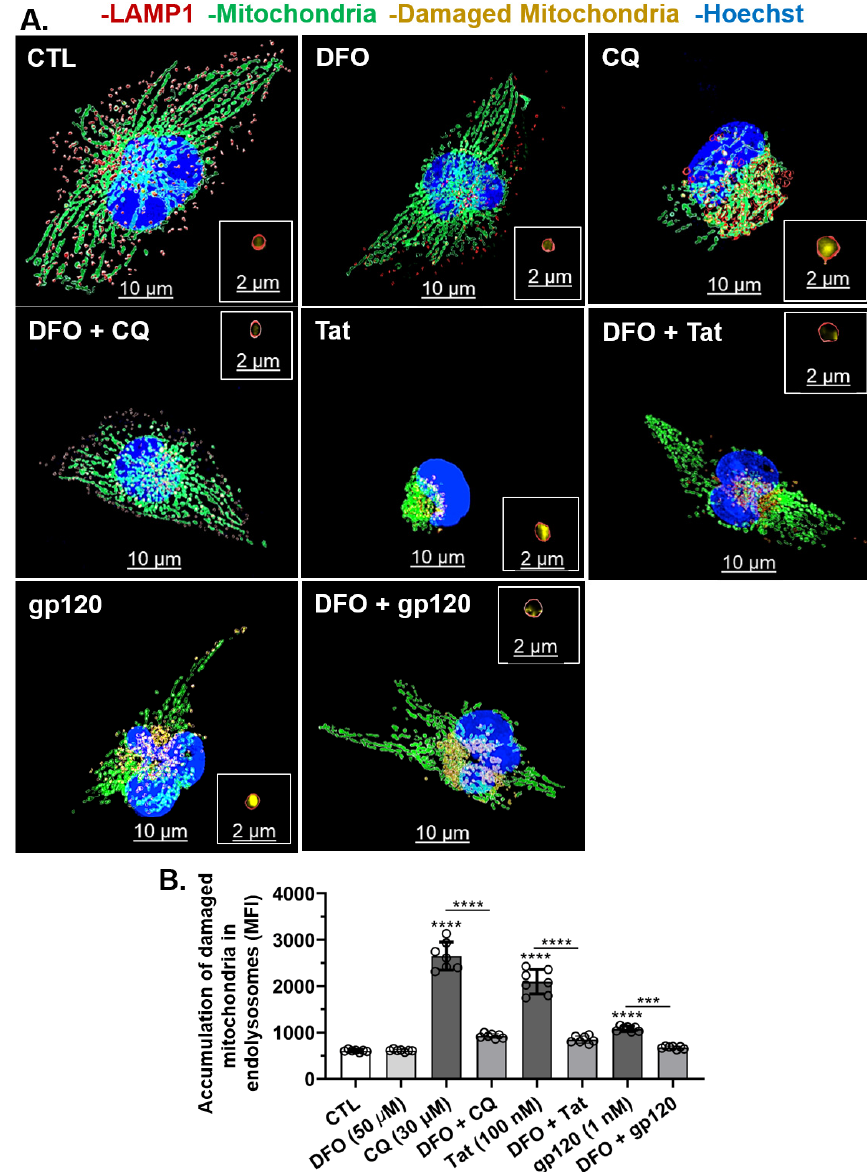
Figure 7. DFO blocked HIV-1 Tat-, gp120-, and CQ-induced increases in the accumulation of damaged mitochondrial fragments inside endolysosomes. ( A ) Representative fluorescence microscopy recon- structed (using Imaris 3D software) images showed late endosome–early lysosome (endolysosome) LAMP-1 RFP (red puncta), mitochondria (CellLight transfection, green), damaged mitochondrial fragments inside endolysosome (yellow puncta) and nuclei (blue). Qualitatively, HIV-1 Tat, gp120, and CQ increased the accumulation of damaged mitochondria fragments inside endolysosomes, and DFO blocked these increases. ( B ) Quantitatively, DFO blocked the accumulation of damaged mitochondrial fragments inside endolysosomes increased by CQ (30 µ M), Tat (100 nM), and gp120 (1 nM). Image analysis and quantification was performed from five independent experiments with 30 cells quantified for each experimental condition ( n = 150). Error bars represent standard deviation (SD) of five independent experiments. A one-way ANOVA multiple comparisons test was used to compare control and treatment groups. Cells were chosen randomly during image acquisition and analysis from the microscope field of view, and no cells were intentionally excluded. Scale bars are 10 µ m for the image and 2 µ m for the inset. *** p < 0.001 and **** p <